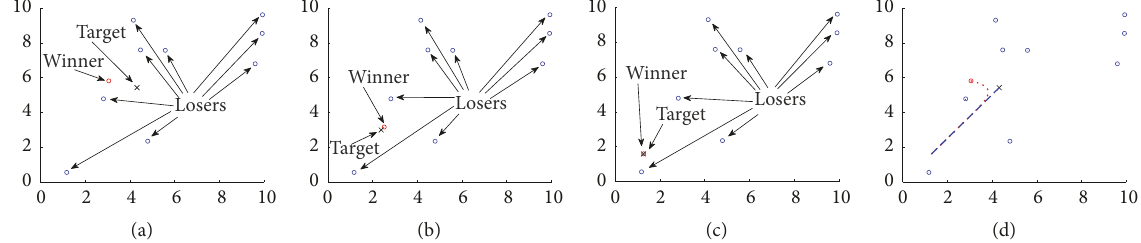
Figure 8: ( Phase 2 ) As the continuation of simulation results shown in Figure 7, this figure shows the tracking trajectory and snapshots for the distributed coordination model (19) with limited communications for tracking the moving target and initial locations of mobile robots being the same as those in Figure 7(c) and the initial location of moving target being generated randomly. Ten mobile robots compete with each other for tracking the moving target, and only the one with the minimum distance from the moving target is activated to track while the rest ones (the losers) keep unmoved. (a) The snapshot at 𝑡 ≈ 4.1 s. (b) The snapshot at 𝑡 = 5 s. (c) The snapshot at 𝑡 = 8 s. (d) Tracking trajectories of different mobile robots.